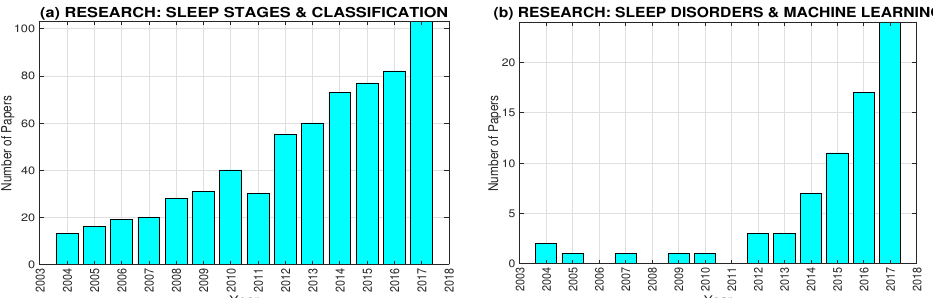
Figure 2. The time evolution of number of journal papers devoted to analysis of ( a ) sleep stages and their classification and ( b ) sleep disorders and machine learning according to the Web of